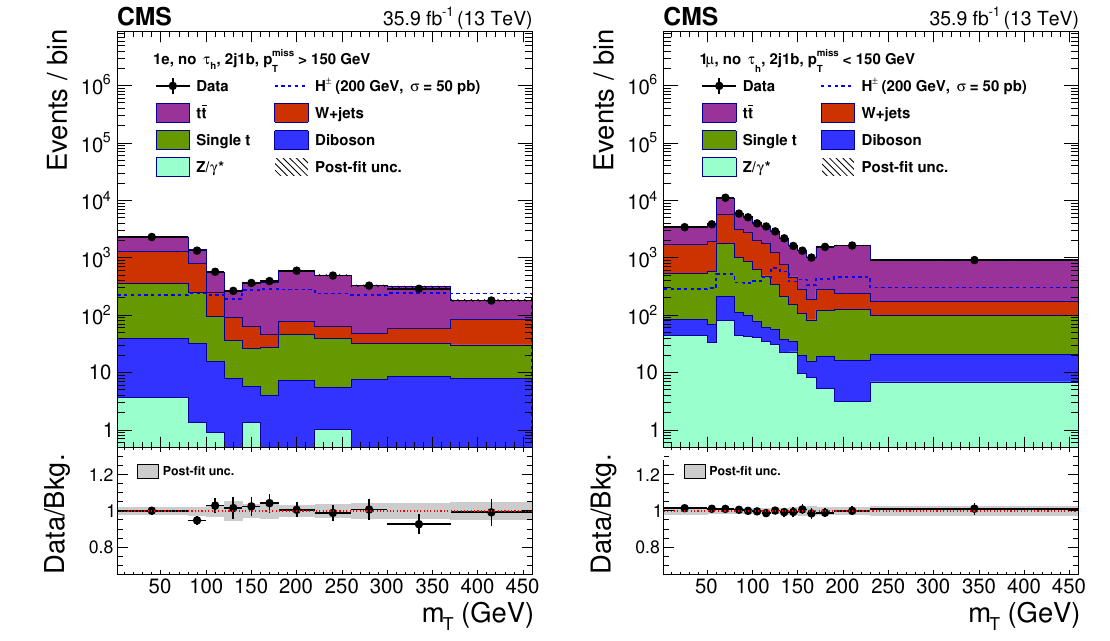
Figure 5 . The m ‘ + no t categories with high signal sensitivity after a T distributions for two h background-only (cid:12)t to the data. Left: category with one electron, no t , two jets (one identi(cid:12)ed h as a b jet), and p miss T > 150 GeV. Right: category with one muon, no t , two jets (one identi(cid:12)ed h as a b jet) and p miss